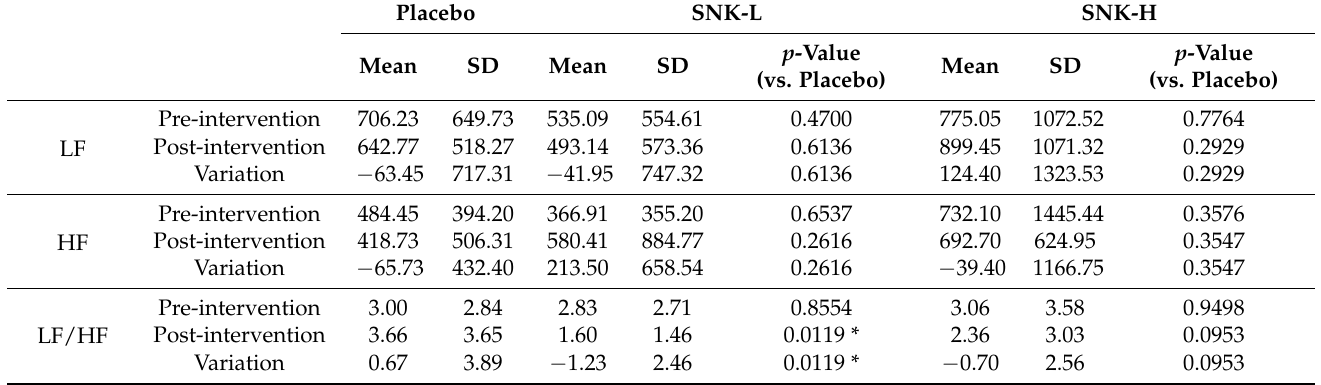
Table 7. Autonomic nerve balance (LF/HF) after stress